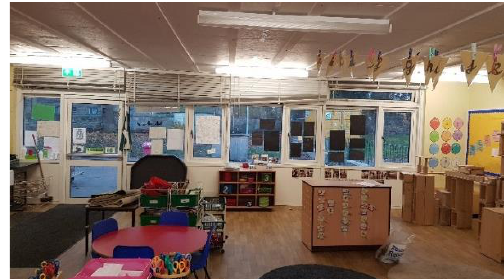
Figure 2. Picture of school A.